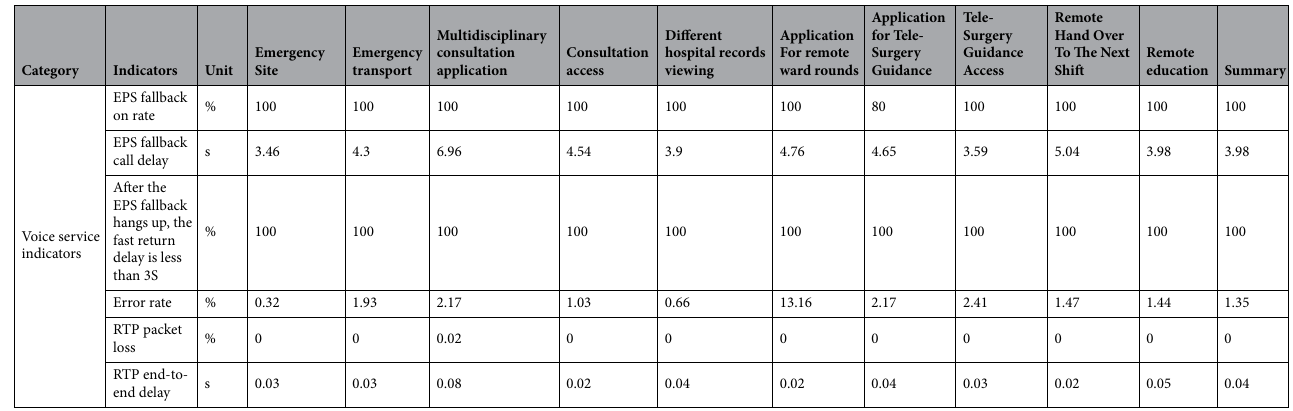
Table 4. Voice service indicator test